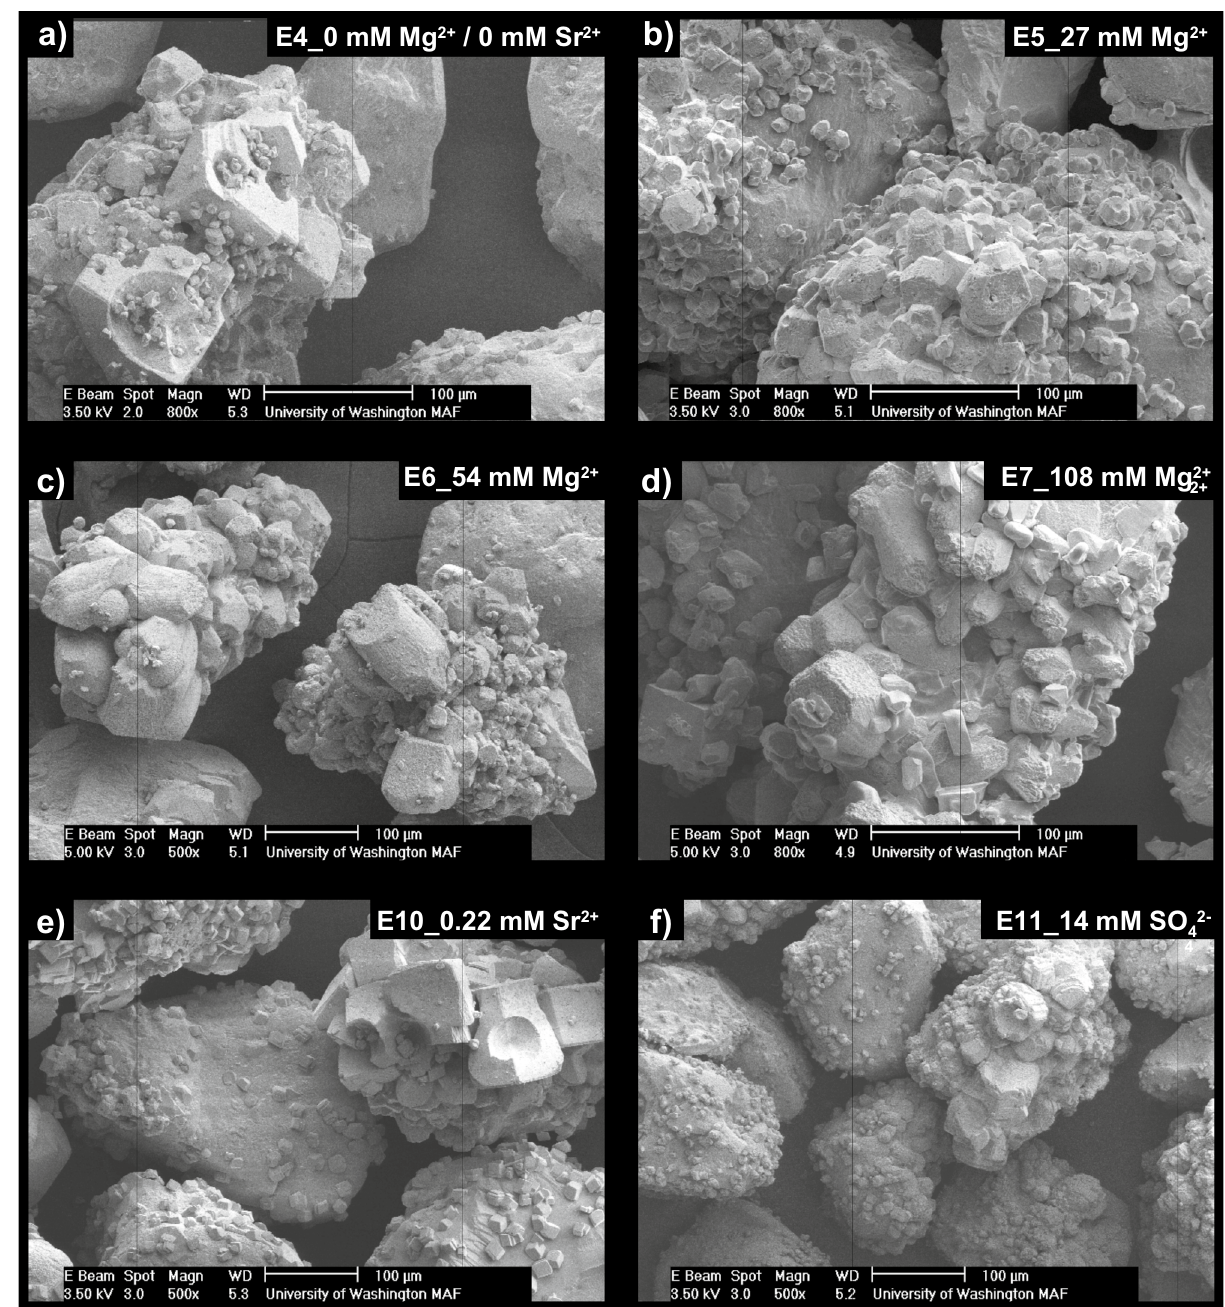
Figure 6. SEM images of precipitates from the ( a ) 0 mM Mg 2+ /0 mM Sr 2+ , ( b ) 27 mM Mg 2+ , ( c ) 54 mM Mg 2+ , ( d ) 108 mM Mg 2+ , ( e ) 0.22 mM Sr 2+ and ( f ) 14 mM SO 42−